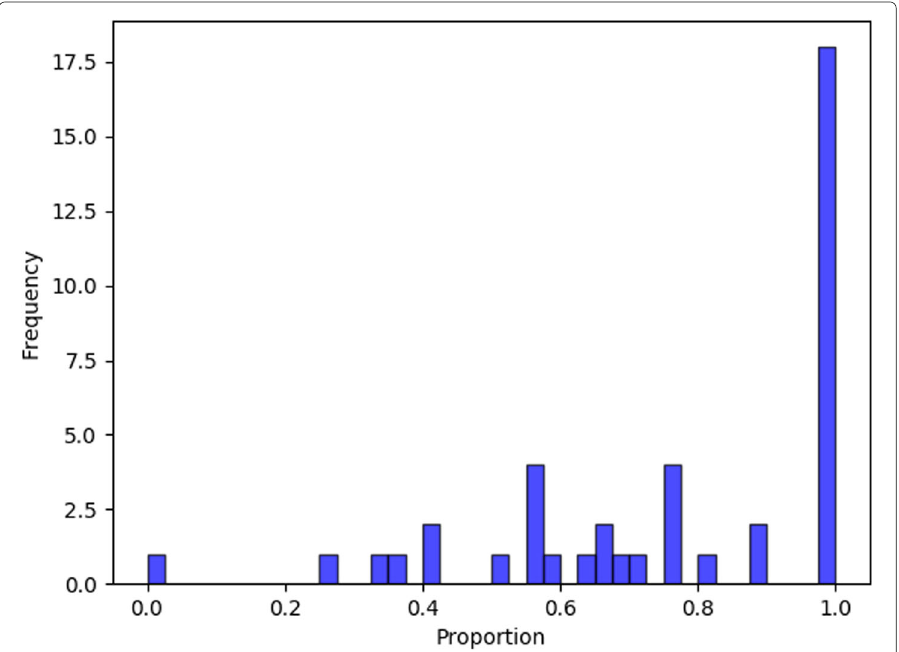
Fig. 3 Proportion of non-operational log-in